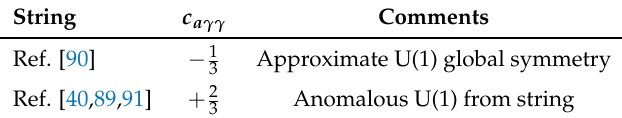
Table 2. String model prediction of c a γγ . In the last line, c a γγ = ( 1 m u = 0.5 m d